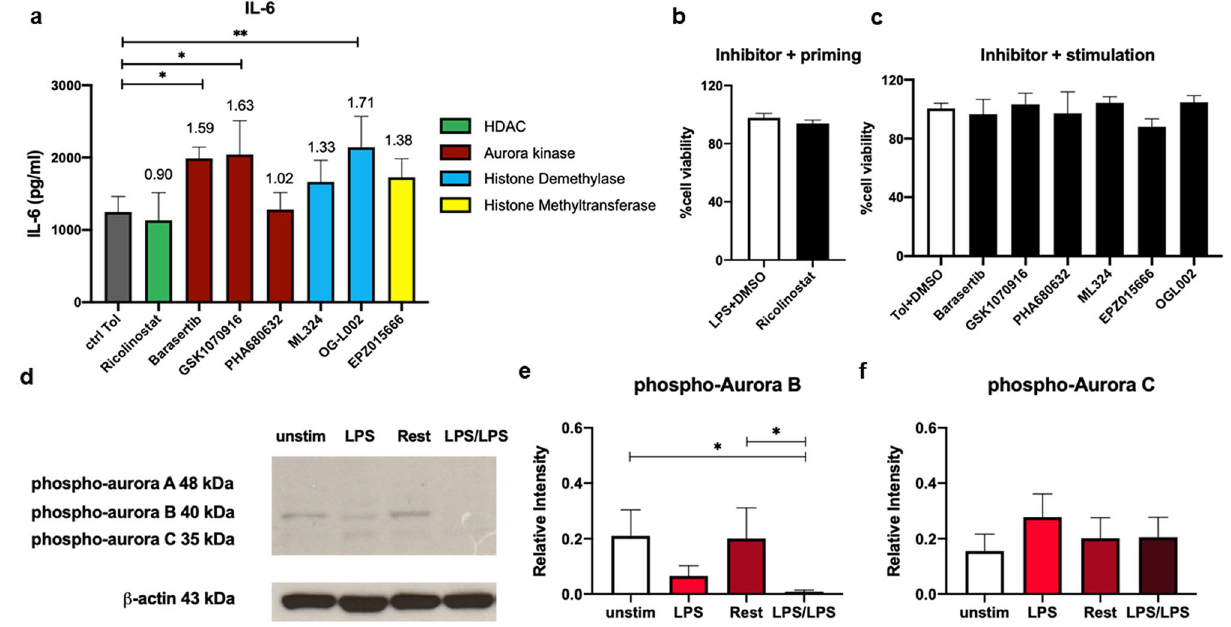
Figure 4. Expression profiles of Aurora kinases in LPS-tolerant macrophages. LPS-tolerant macrophages were prepared as described above. ( a ) IL-6 production after treatment with selected inhibitors from Fig. 3a was measured by ELISA at 24 h after LPS stimulation. ( b, c ) Cell viability was detected by MTT assay at 24 h after treatment with inhibitors from ( a ). ( d - f ) Phosphorylation of Aurora kinases was analyzed by Western blot. The relative intensity from Western blot was quantitated by ImageJ analysis and normalized to β-actin. *, **, *** and **** indicate significant differences compared by one-way ANOVA with Dunnett’s multiple comparison test ( a ) and two-tailed unpaired t-test ( d ) at p < 0.05, p < 0.01, p < 0.001 and p < 0.0001,